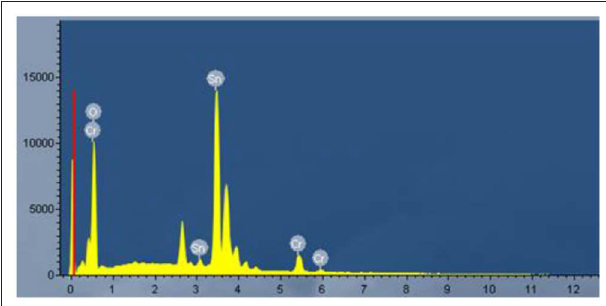
FIGURE 5 | The EDS spectrum of Cr 2 O 3 NPs. coated SnO 2 NFs.